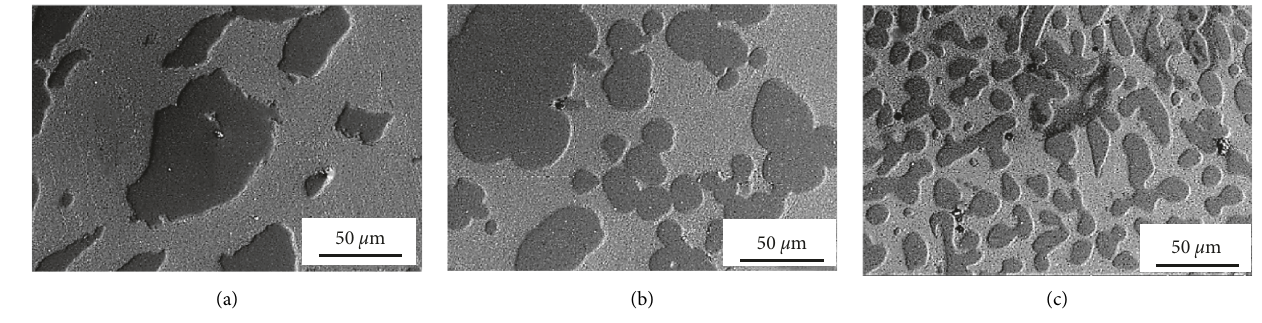
Figure 8: Microstructure of CuCr alloy prepared by different preparation methods [58]. Table 1: Properties of CuCr alloy prepared by different preparation methods